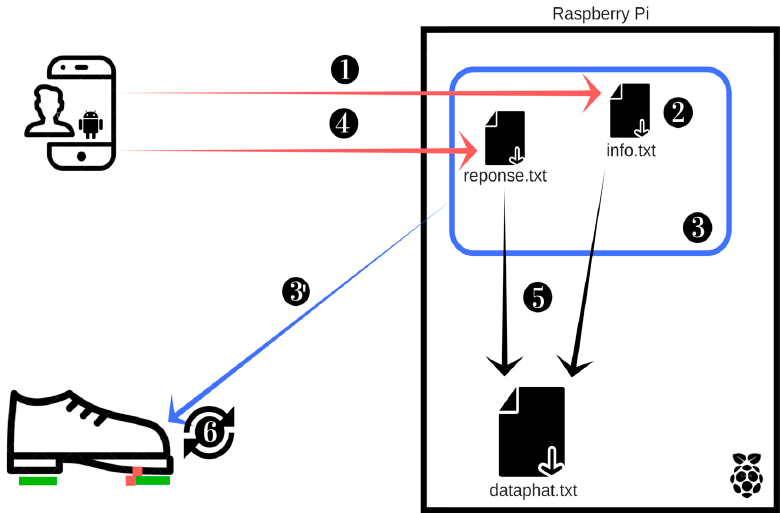
Figure 5. Experiment synopsis. 1. Sending the parameters of the experiment and